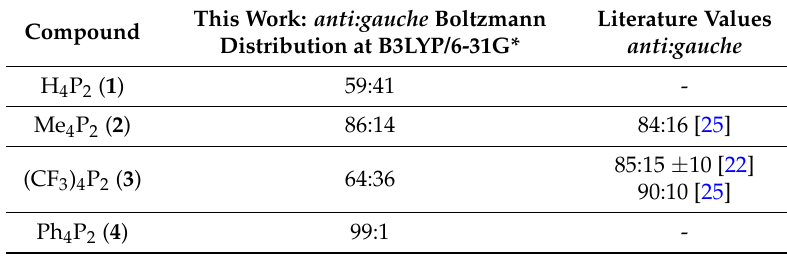
Literature Values